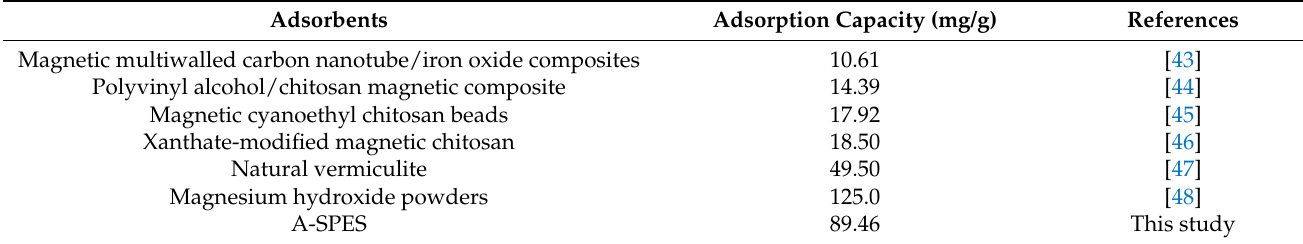
Table 3. Selected adsorption capacity reports for Co(II) with different